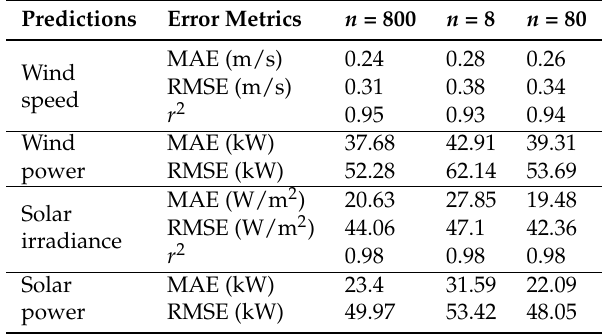
Table 4. Forecasting simulation results in terms of performance evaluation metrics.